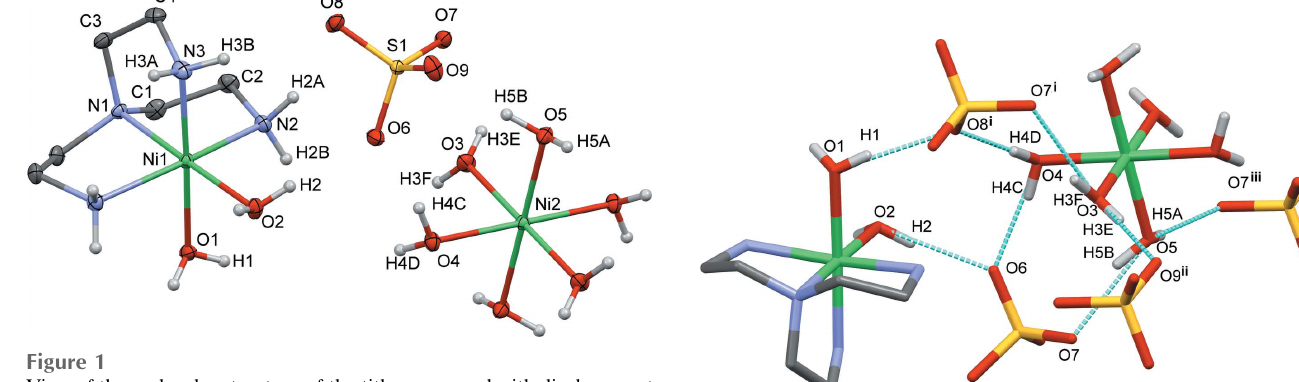
, y , (cid:2) z + 3 ; (ii) (cid:2) x + 1 , (cid:2) y + 1, z (cid:2) 1 ; (iii) (cid:2) x + 1 , 2 2 2 2 2 315